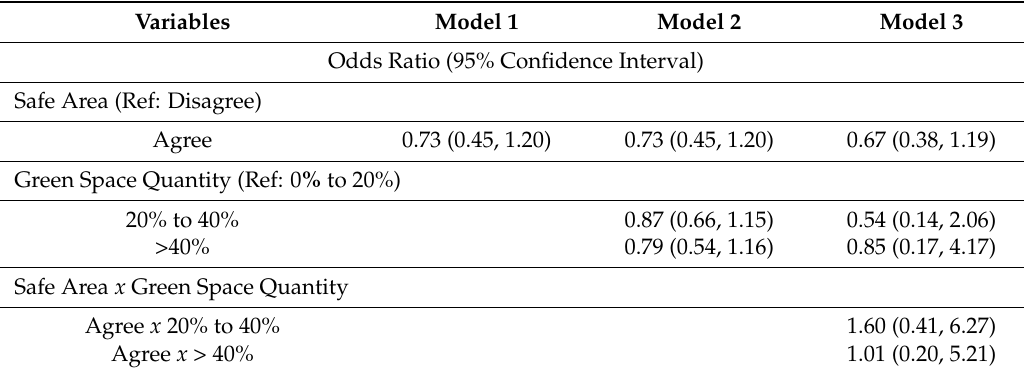
Table 3. Associations and effect measure modification of the association between heavy traffic and child affirmative asthma across strata of green space